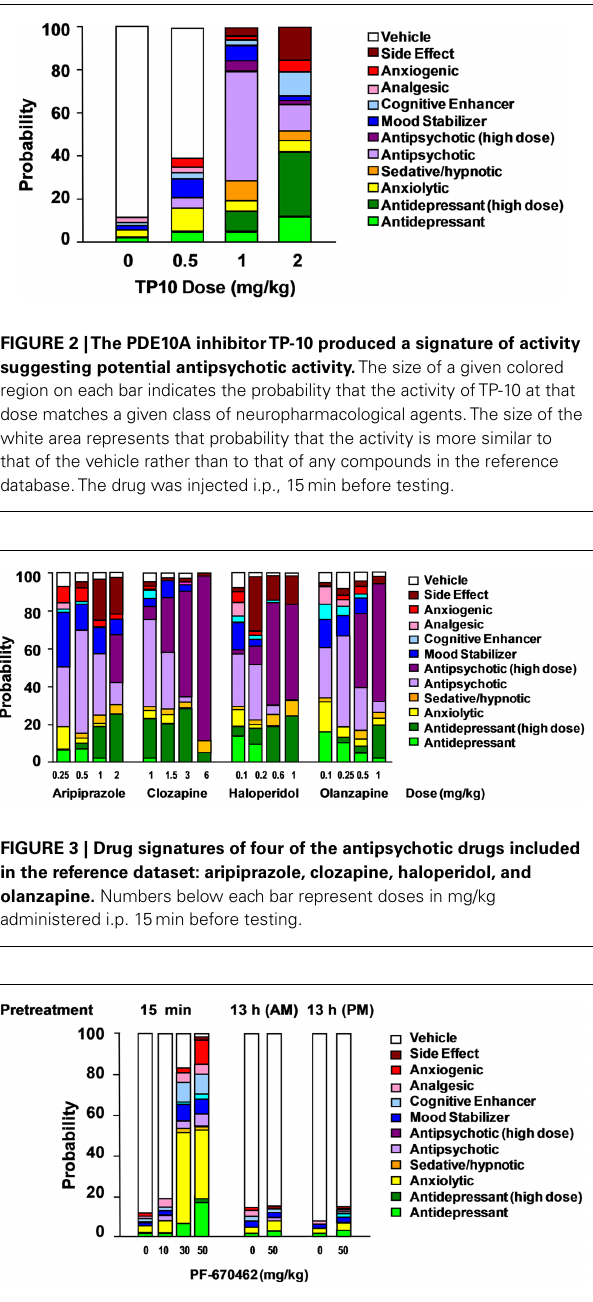
FIGURE 4 |The CK1 ε inhibitor PF-670462 demonstrated a signature consistent with anxiolytic activity (yellow) and, at the highest dose tested, behavioral effects similar to that of opiate analgesics (pink), although this dose is higher that doses tested previously in rodents and may reflect non-specific effects. The drug was injected i.p. 15min before the test in studies represented by the five left-most bars of the chart.To assess potentially delayed behavioral effects due to its effects on circadian rhythm, PF-670462 was injected s.c. 13h before testing in the morning (AM) or in the afternoon (PM).This procedure revealed no delayed